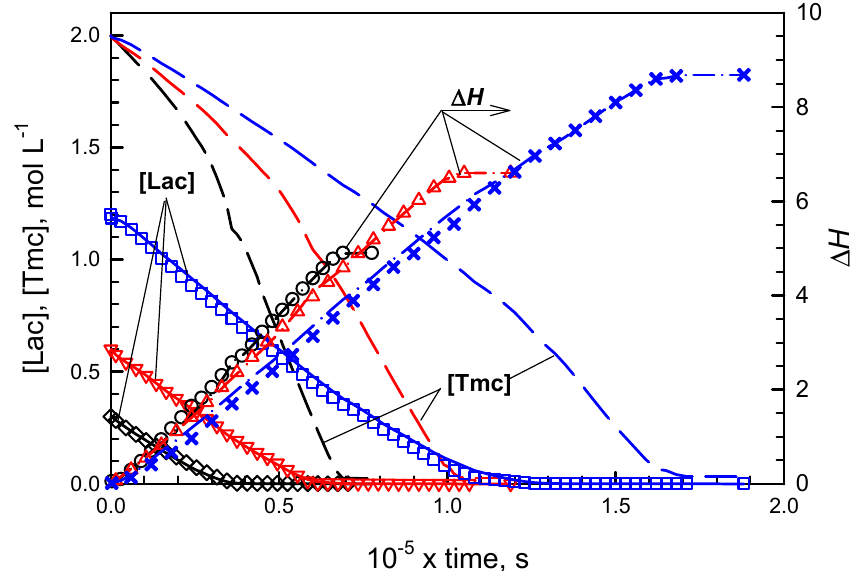
Figure 3. Experimental and simulated evolution of [ Lac ], [ Tmc ], and ∆ H in copolymerizations initiated with S - Ini . Plots description and copolymerization conditions as given in caption for Figure 2, but R - Ini enantiomer was used.